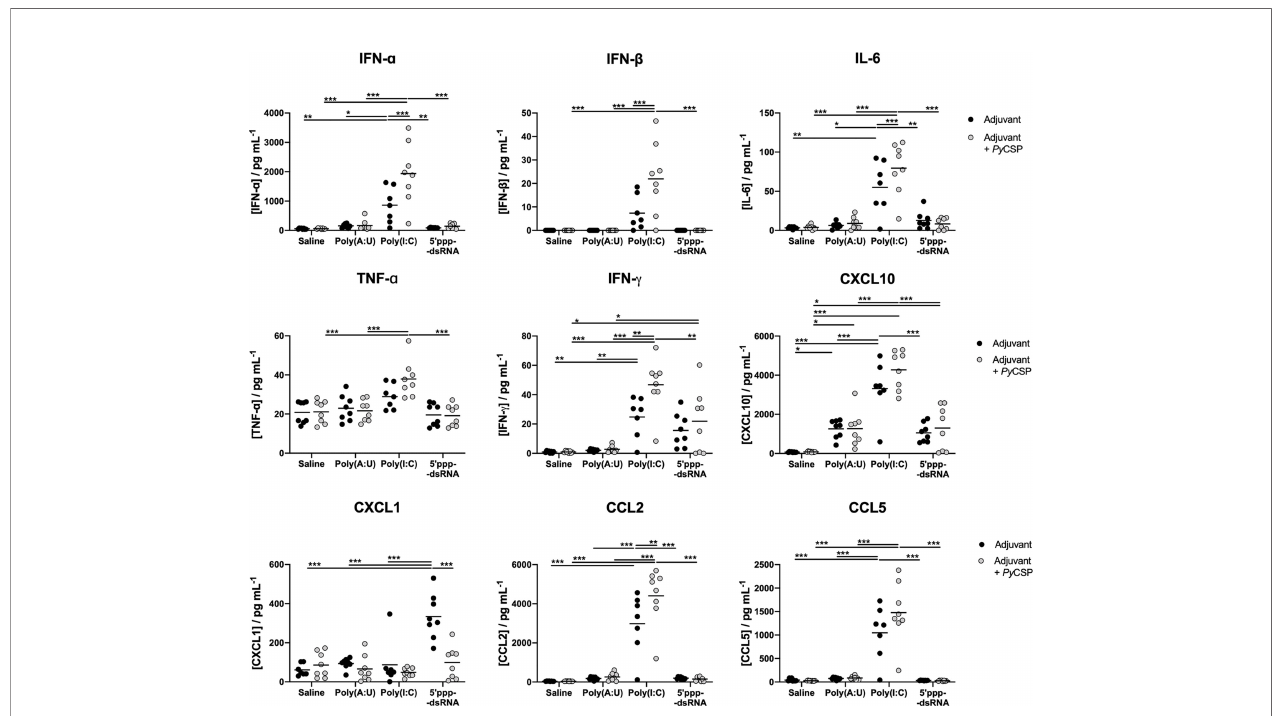
FIGURE 7 | Systemic cytokine and chemokine production following administration of the different combinations of adjuvants and Py CSP. The concentration of several cytokines and chemokines was determined in the peripheral blood of immunized mice 5 hours after the fi rst administration of the immunization mixtures and respective controls. Concentrations of IFN- a , IFN- b , IFN- g , TNF- a and IL-6 and chemokines CCL2, CCL5, CXCL1 and CXCL10 were determined, using a Multiplex assay, in pg/mL. Symbols represent individual values and black lines the mean of each group for two independent experiments (n = 8). Statistical signi fi cance was determined by two-way ANOVA with Bonferroni ’ s multiple comparisons test. *p ≤ 0.05; **p ≤ 0.01; ***p ≤